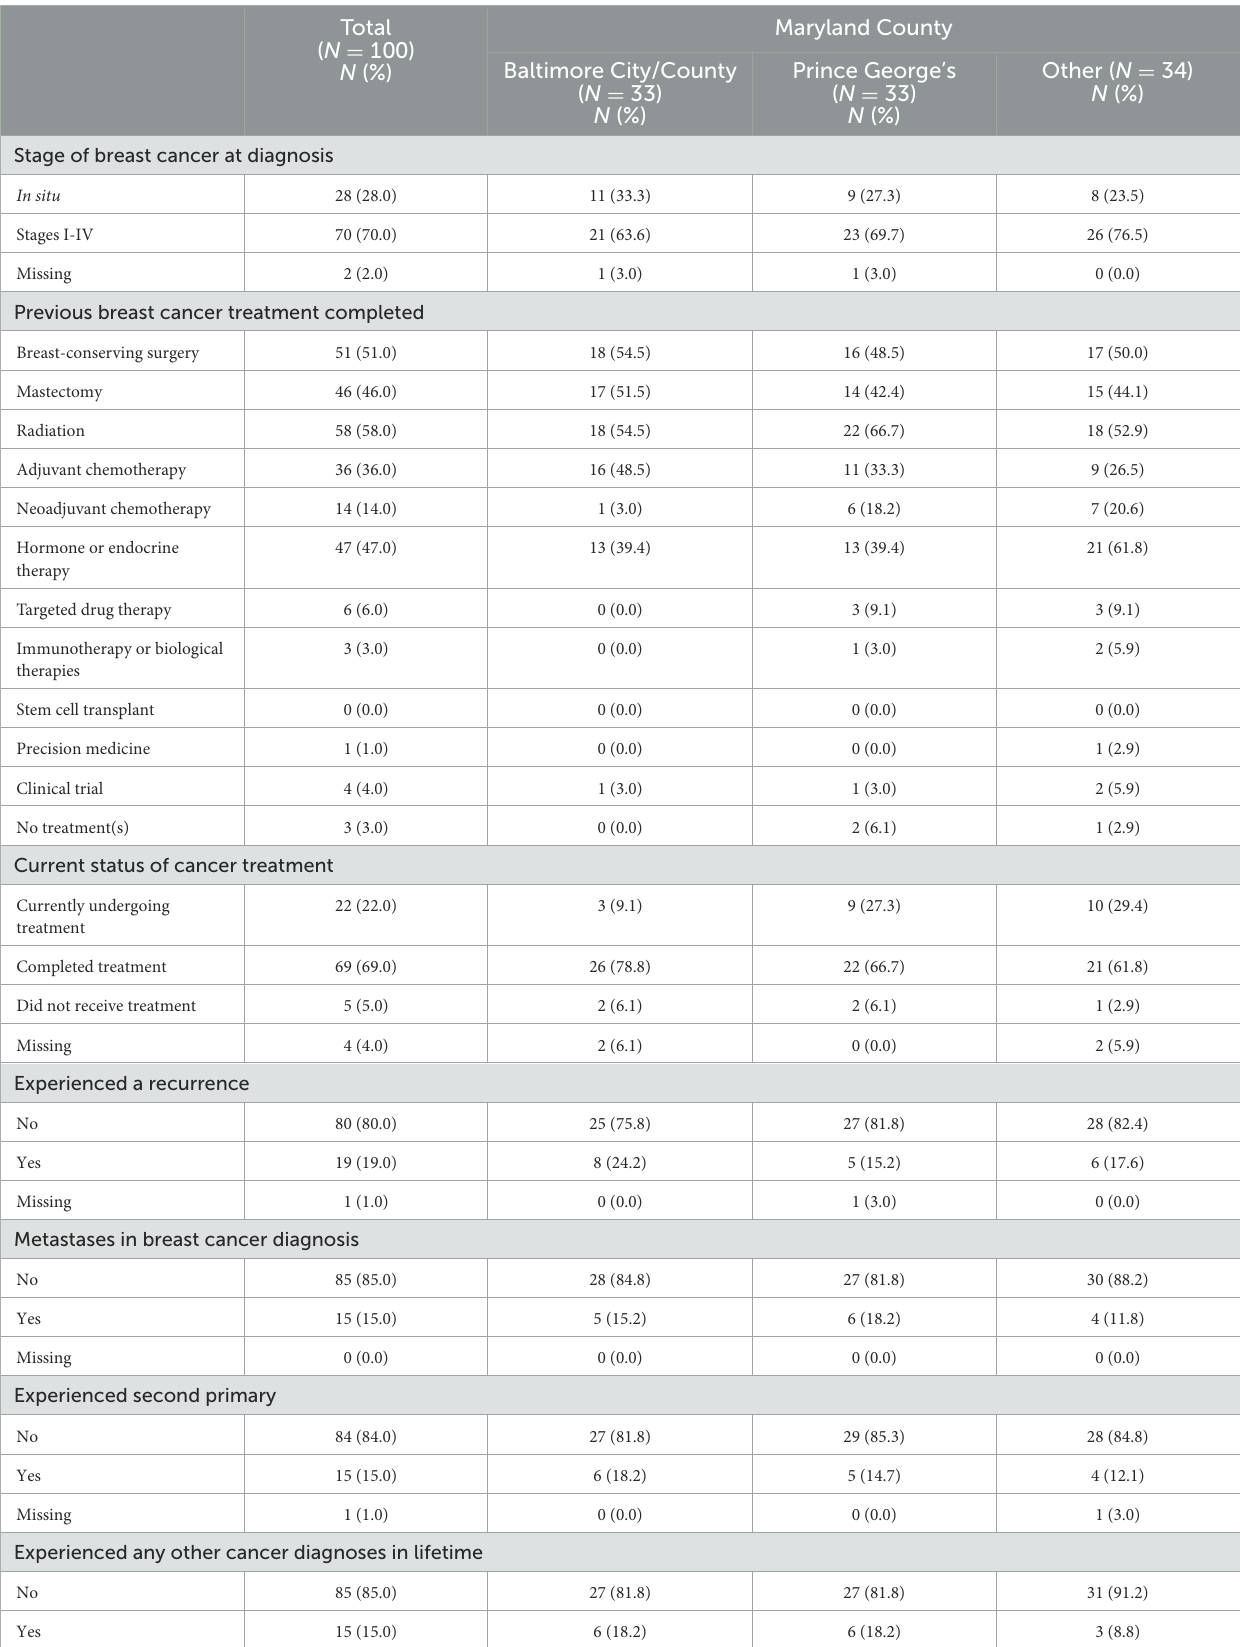
TABLE 2 Clinical cancer characteristics of the study population overall and stratified by Maryland county ( N =